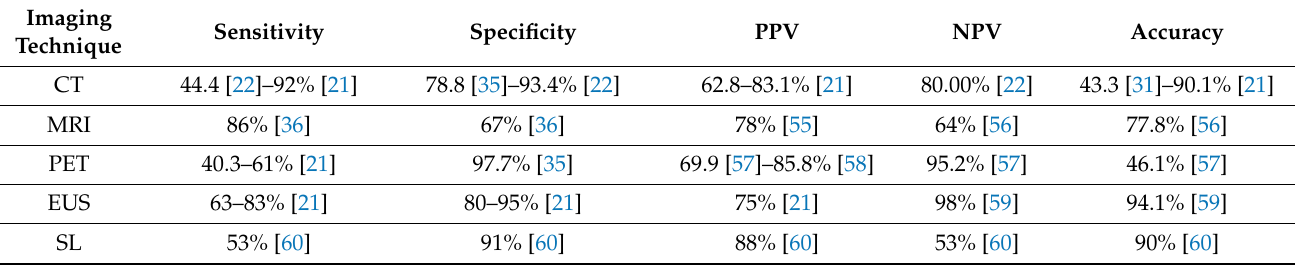
Table 1. Comparison of selected imaging techniques for nodal staging in advanced